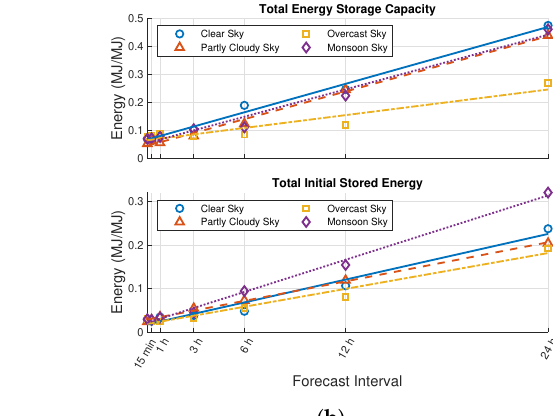
Figure 9. The load energy forecast differences for each of the four atmospheric sky conditions. ( a ) The clear sky load energy forecast differences. ( b ) The partly cloudy sky load energy forecast differences. ( c ) The overcast sky load energy forecast differences; ( d ) The monsoon sky load energy forecast differences.